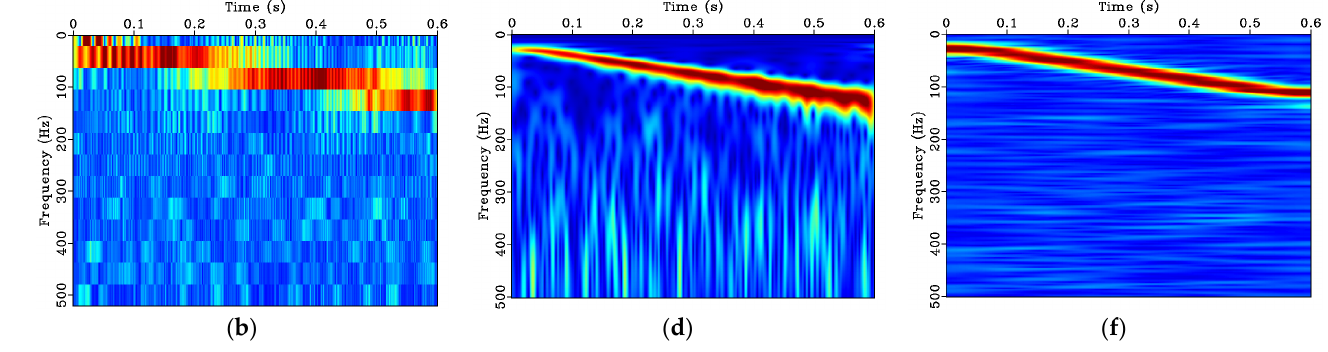
Figure 7. Time-frequency spectra for the linear frequency-varying signal: ( a ) STFT spectrum; ( b ) STFT spectrum of noisy signal; ( c ) ST spectrum; ( d ) ST spectrum of noisy signal; ( e ) LTFT spectrum; ( f ) LTFT spectrum of noisy signal. The jet colormap is used where blue and red represent low and high frequency magnitudes, respectively.